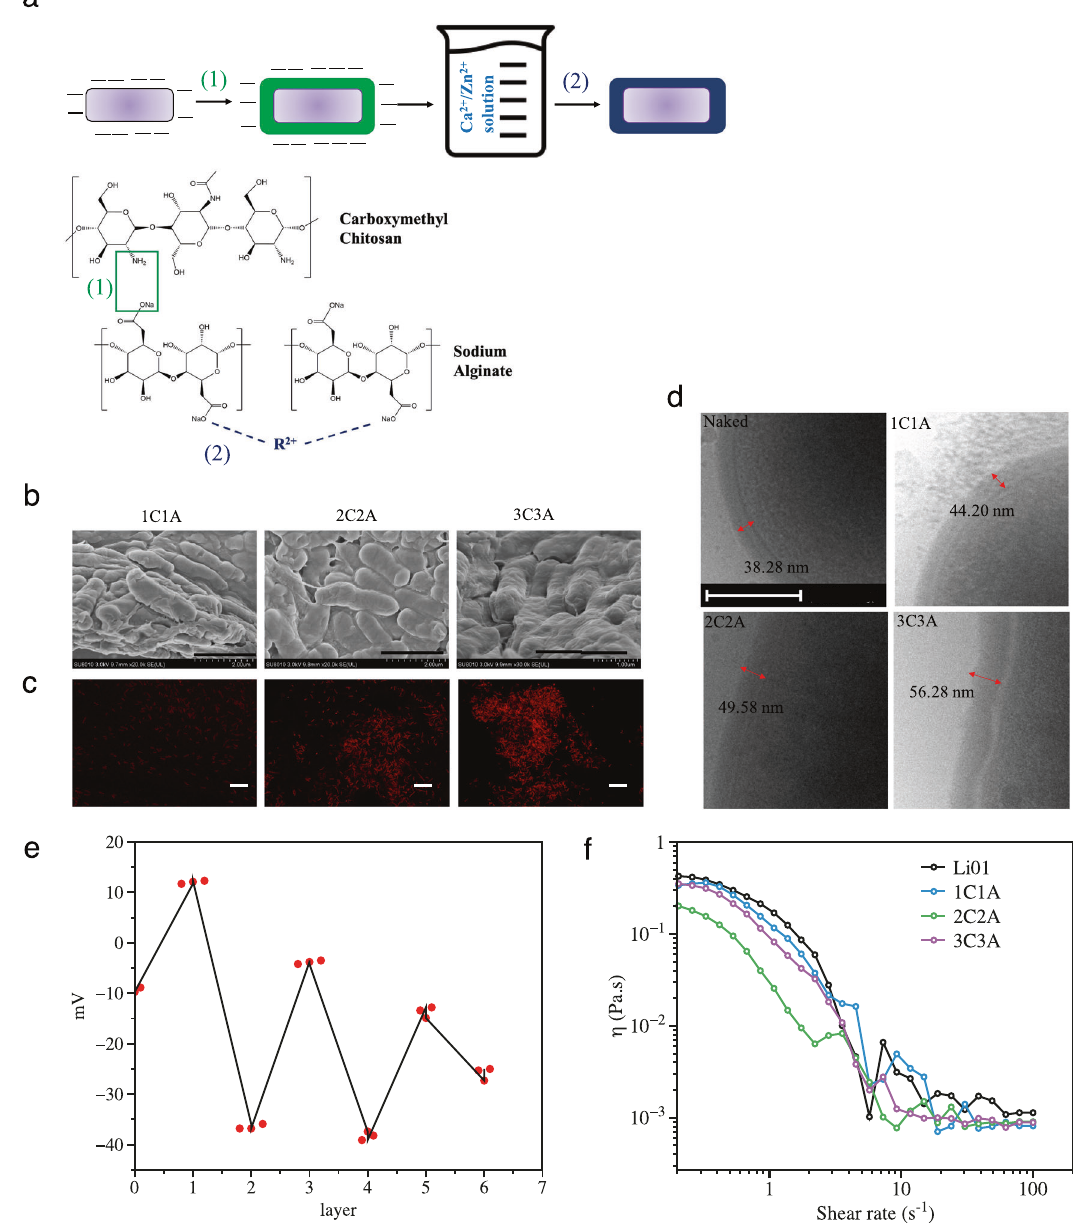
Fig. 1 Characterization of LbL Li01. Preparation progress of LbL Li01 and was shown in ( a ). Step (1) shows the molecular reactions between alginate and chitosan to form bilayer; step (2) shows cross-linking formed between alginate molecules. Characterization of morphologies of Li01 cells coated with one (1C1A), two (2C2A), and three (3C3A) bilayers by scanning electron microscopy (SEM, scale bars represent 2.0 μ m) ( b ) and confocal microscopy (scale bars represent 50 μ m) ( c ). The membrane thickness of Li01 cells and cells coated with 1 – 3 bilayers were determined by cryo-TEM (scale bars represent 200 nm) ( d ). The ζ -potential was measured when each layer was added ( e ). The apparent viscosity of Li01 cells coated with 1 – 3 bilayers was measured with the shear rate ranging from 0.2 s − 1 to 100 s − 1 ( f